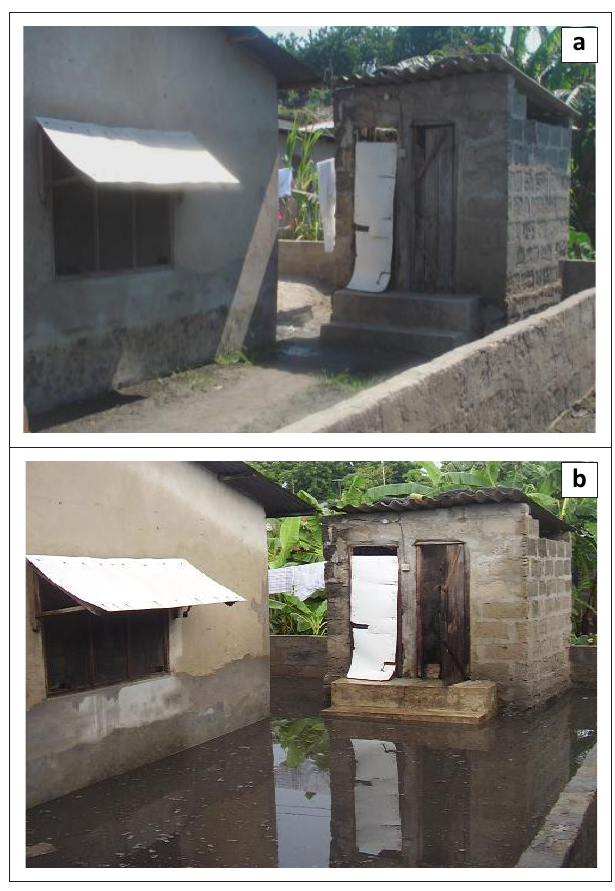
FIGURE 8 : Construction of protective walls (a) before rainfall and (b) after rainfall.